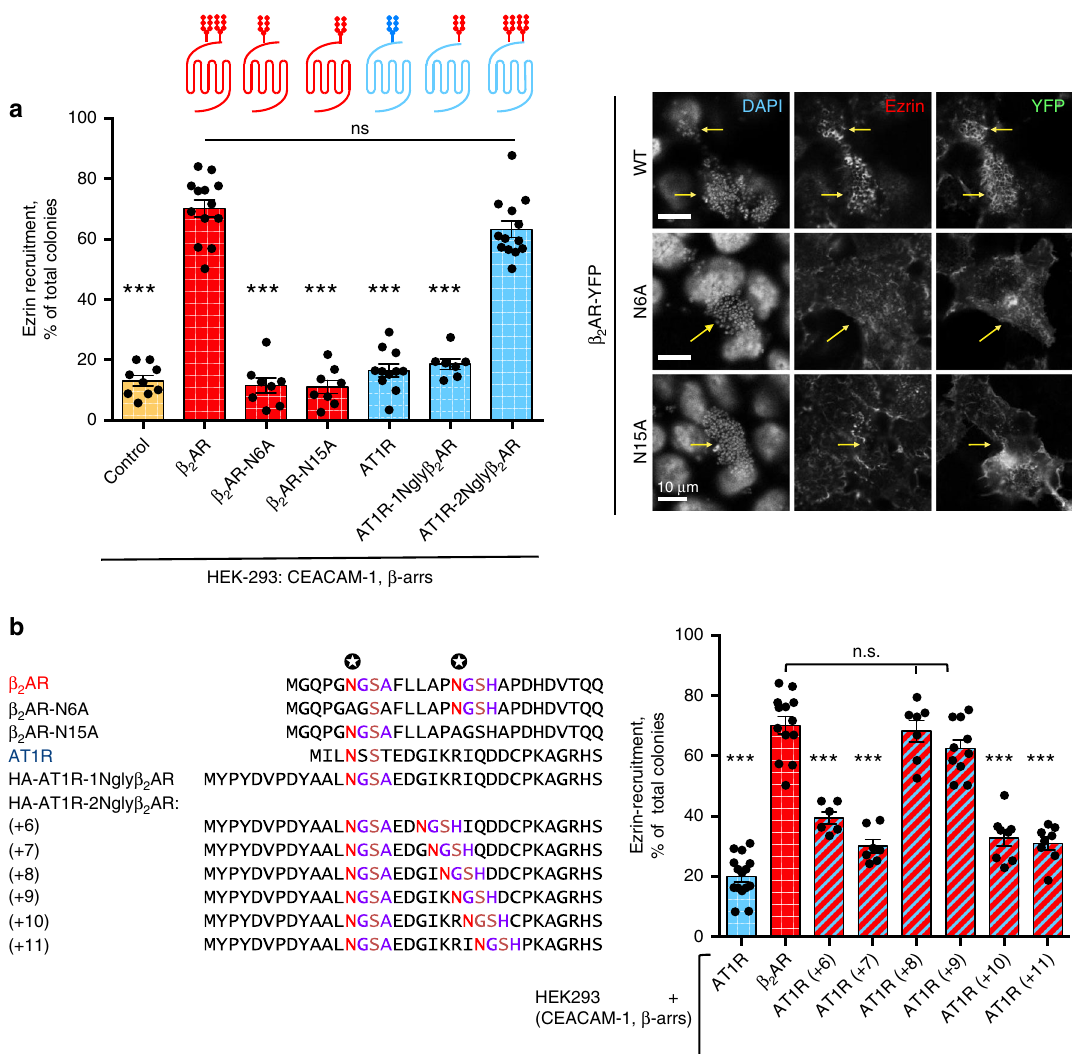
Fig. 2 Role of glycan chains in meningococcus-promoted β 2 AR signaling. a , Left panel: ezrin recruitment assays were as in Fig. 1d; the percentage of ezrin- recruiting colonies was quanti fi ed in controls and in cells expressing human CEACAM-1, β -arrestins ( β -arrs) and YFP-tagged forms of: wild-type β 2 AR, mutant β 2 AR lacking either N-glycosylation site ( β 2 AR-N6A and β 2 AR-N15A), wild-type angiotensin AT1R, and mutant AT1R expressing either the fi rst β β β + 9)). Red drawings represent the β 2 AR N-glycosylation signal (AT1R-1Ngly 2 AR), or both signals (AT1R-2Ngly 2 AR ( 2 AR polypeptide and its N-glycan chains. The blue diagram represents the AT1R polypeptide with its single N-glycan chain. In mutant AT1R receptors, the N-glycan chains branched on the N-glycosylation signals from the β 2 AR are represented in red. Histograms represent mean values ± SEM ( n = 6) (*** p < 0.001 control or mutants vs. wild- type β 2 AR, ANOVA with Bonferroni multiple comparison test; n.s.: not signi fi cant difference). Right panel: representative IF images of the experiment; arrows indicate the position of bacterial colonies; ezrin indicates the labeling with anti-ezrin antibodies and YFP corresponds to the signal of YFP-tagged receptors. b HEK-293 cells expressing CEACAM, β -arrestins, and the indicated receptors were prepared, infected, and processed as in a . Left panel: sequence alignment of receptor N-termini (constructs used in a , b ). Asparagine residues used for glycan branching on wild-type β 2 AR are marked by stars. HA-AT1R-1Ngly β 2 AR and HA-AT1R-2Ngly β 2 AR correspond to AT1R mutants expressing one or both β 2 AR N-glycosylation signals, respectively; the numbers within parentheses correspond to the distance between N-glycosylation signals, ( + 9) being the distance found in wild-type β 2 AR N-terminus; β β β 2 AR-N6A and 2 AR-N15A are mutant 2 ARs lacking either N-glycosylation site. Right panel: role of the distance between N-glycosylation sites on meningococcus-promoted ezrin recruitment. Histograms represent mean values ± SEM; ANOVA with Bonferroni's multiple comparison test: *** P <